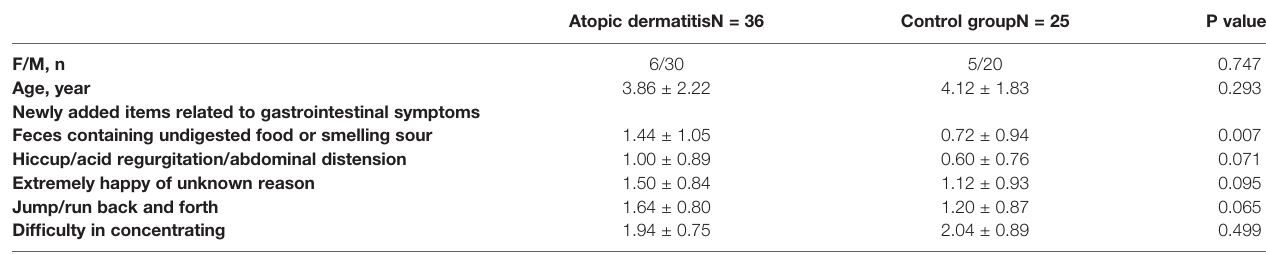
TABLE 1 | The basic characteristics of enrolled autistic children with atopic dermatitis and controls.